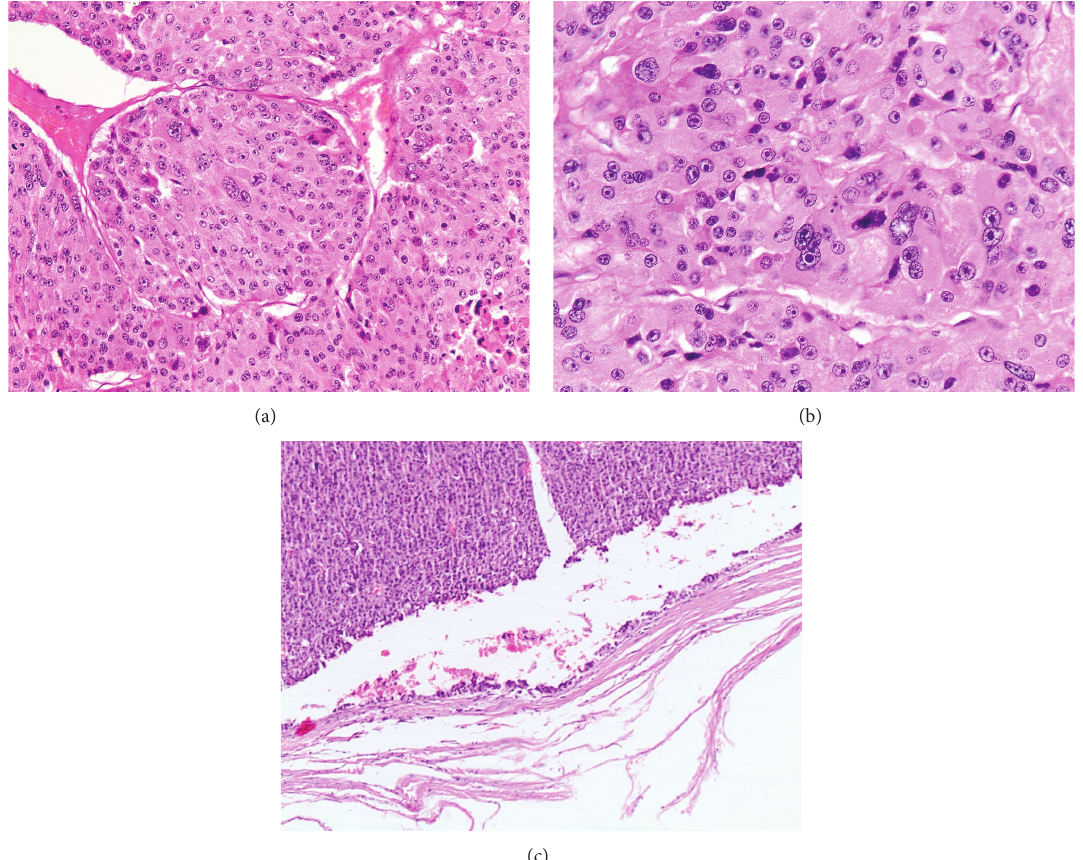
Figure 2: Adrenal carcinoma. (a) 200x magnification. (b) Pathologic view showing atypical mitoses, 400x magnification. (c) Pathologic view demonstrating capsular invasion, 100x magnification.